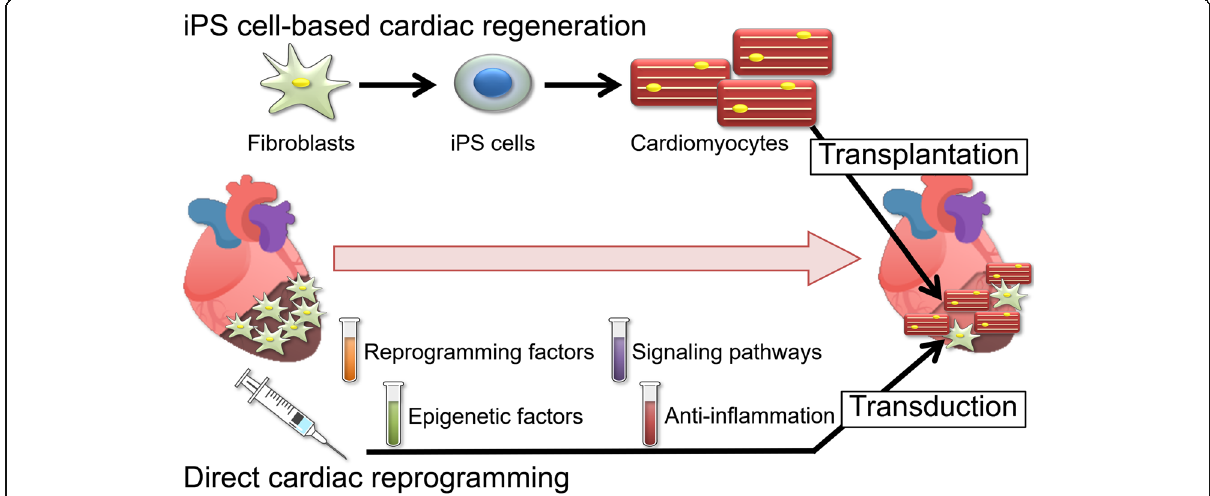
Fig. 2 Schema of future heart regenerative medicine. The outline of heart regenerative medicine in the case of myocardial infarction is shown. When the heart is damaged due to myocardial infarction, heart failure, and so on, cardiomyocytes are preferentially lost. The fibroblasts of the heart remain and replace the lost cardiomyocytes. Currently, a method of transplanting iPS-derived cardiomyocytes is becoming a reality (upper side). Another method is the transduction of the cardiomyocytes based on the remaining fibroblasts. This is the direct cardiac reprogramming (lower